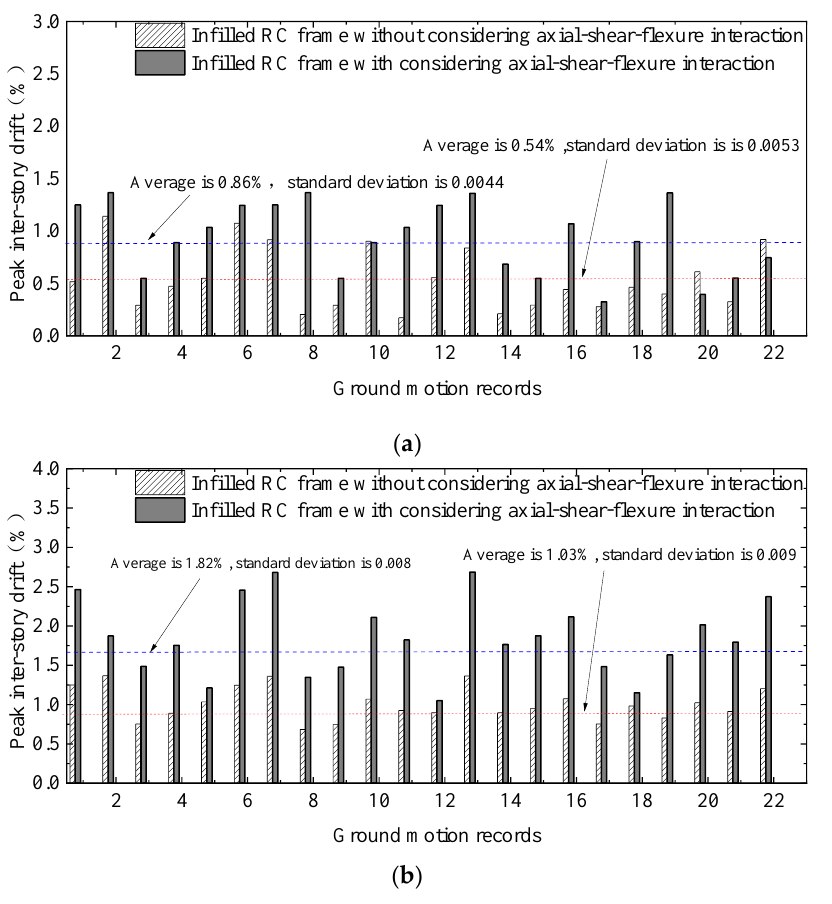
Figure 16. Maximum inter-story drift ratio of structures under 22 ground motions. ( a ) Fortification earthquakes. ( b ) Rare